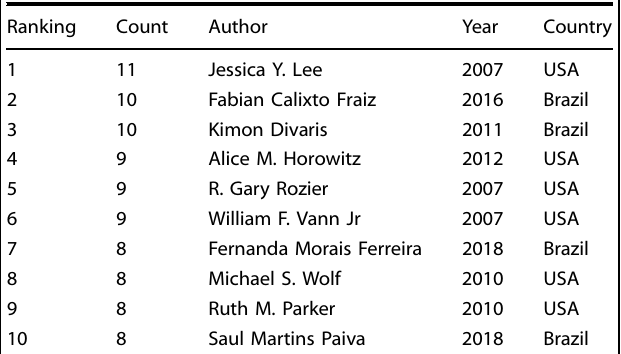
“ psychology ” , and “ surveys and questionnaire ” emerged. New keywords for 2019 and 2020 included “ community ” , “ human experiment ” , and “ validity ” .